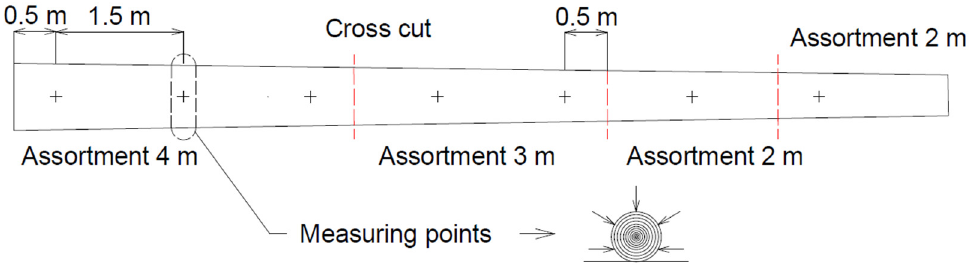
Figure 3. Location of moisture measuring points on the trunk.